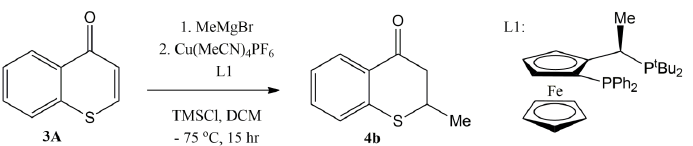
Figure 9. Enantioselective Cu-catalyzed conjugate addition of MeMgBr to thiochromones.